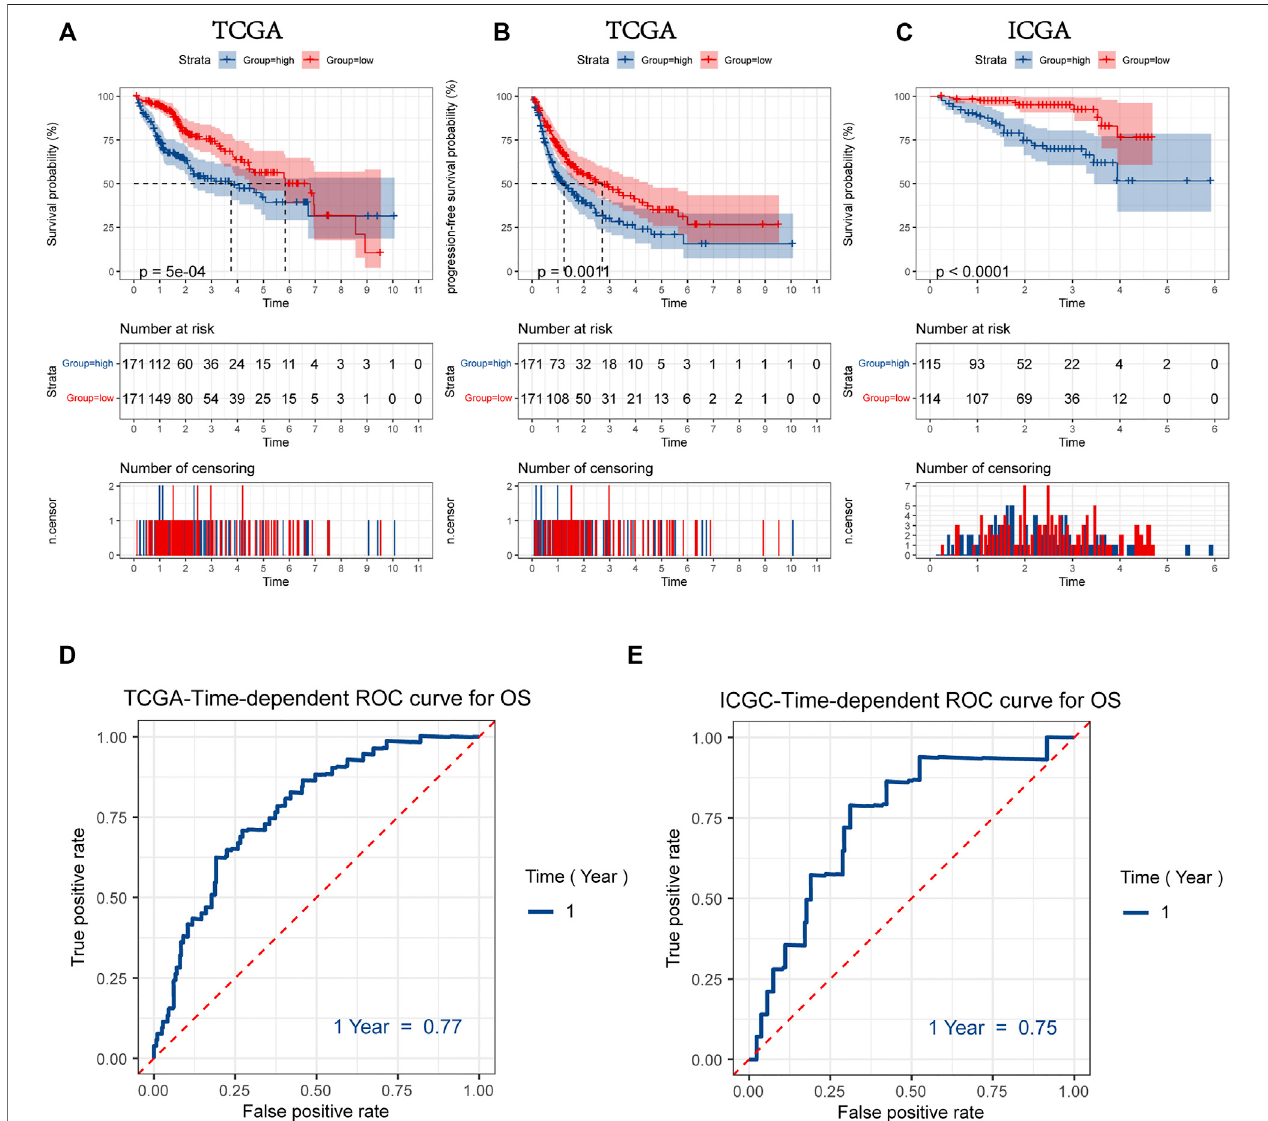
FIGURE5| Kaplan-Meierplotsforoverallsurvival(OS) (A) andprogression-freesurvival(PFS) (B) ofHCCpatientswithahighorlowmitophagyscoreinTCGALIHC cohort (C) Kaplan-Meier plots for overall survival (OS) of HCC patients with a high or low mitophagyscore in ICGC cohort. ROC curves for predicting 1-year OS by mitophagyscore TCGA LIHC cohort (D) and ICGC cohort (E) .